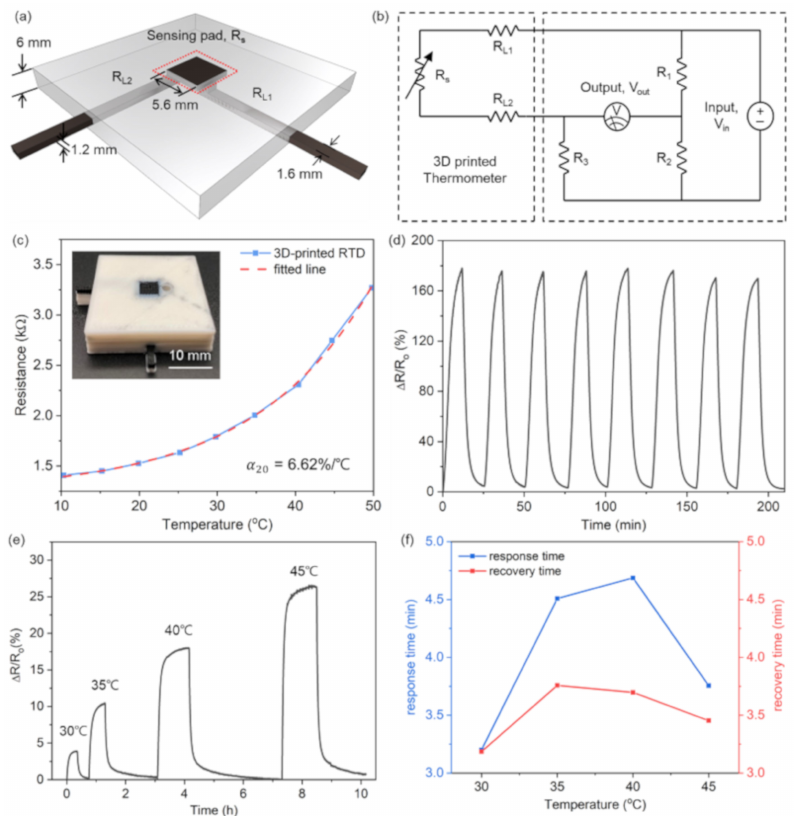
Figure 3. ( a ) Schematic of the proposed planar-type resistance temperature detector (P-RTD) and its dimension for 3D printing; ( b ) equivalent circuit of the P-RTD (dashed box on the left) and the Wheatstone bridge (dashed box on the right); ( c ) resistance change of the P-RTD with the applied temperature, along with the fitted line with a temperature coefficient of resistance (TCR) of 6.62 %/ ◦ C; ( d ) stable operation of the P-RTD during the temperature change cycle; ( e ) resistance change in the RTD over time when increasing the temperature from 30 to 45 ◦ C with 5 ◦ C intervals; ( f ) response and recovery time of the